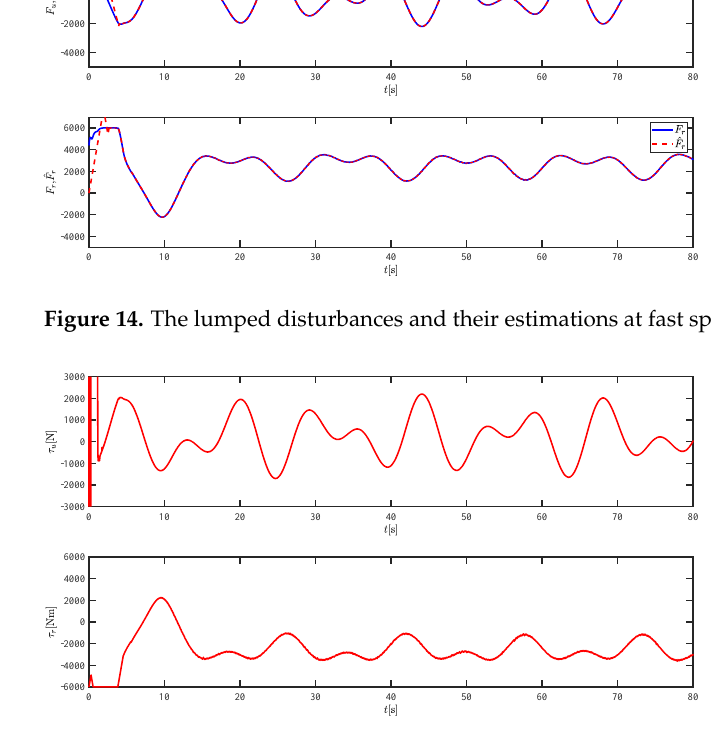
Figure 15. The force τ u and moment τ r at fast speed.